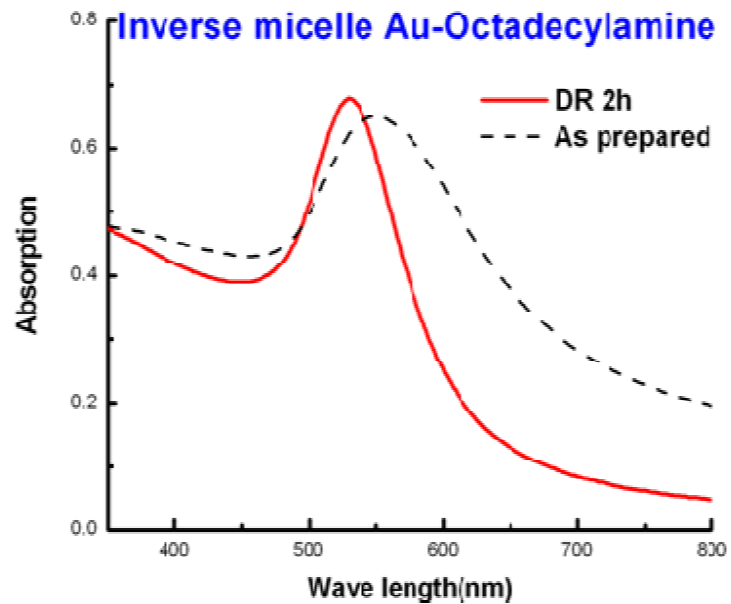
Figure 13. UV-Visible spectrum of Au-octadecylamine colloid before and after digestive ripening 2 h in